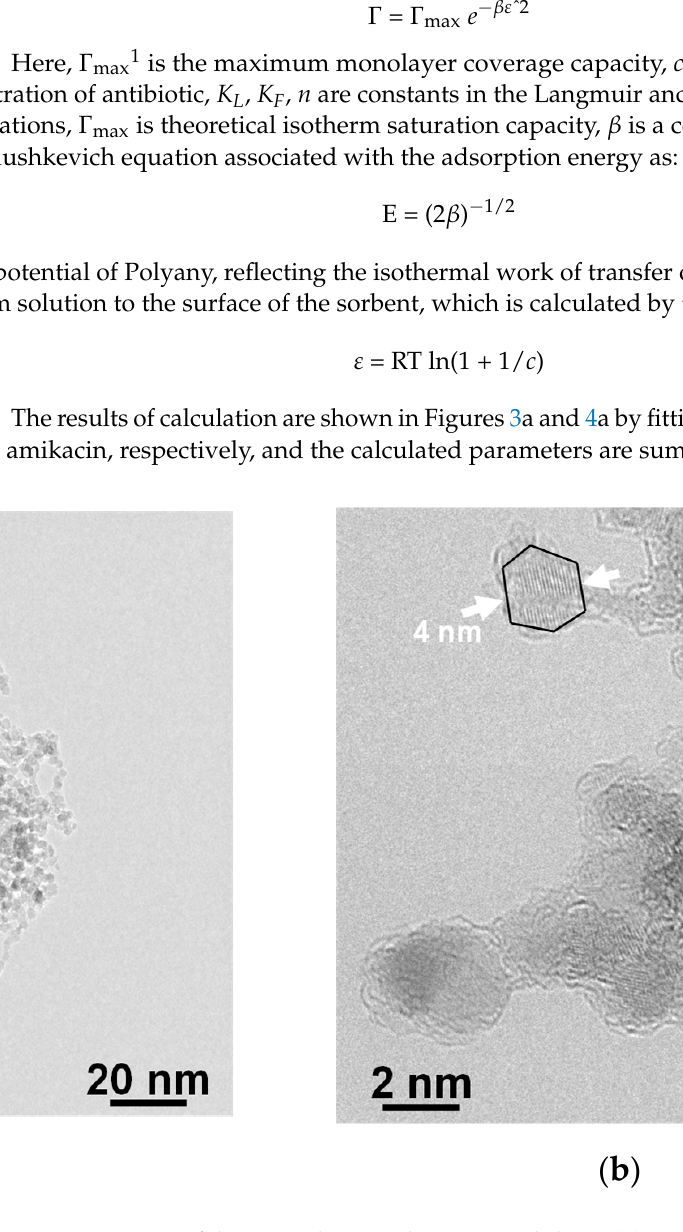
Figure 2. TEM images of the original DND. The image scale bar is ( a ) 20 nm, ( b ) 2 nm. Table 1. Fitting parameters calculated for the dependences of antibiotics surface concentration on its equilibrium